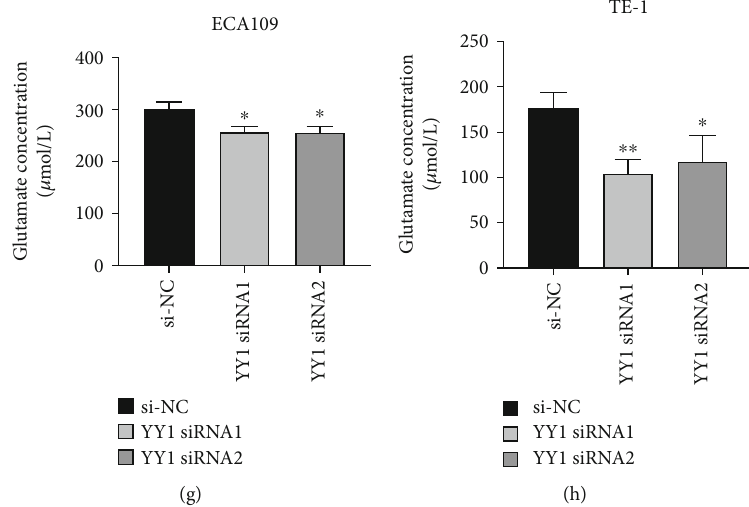
Figure 6: Silencing YY1 inhibited proliferation and glutamine metabolism of ECA109 and TE-1 cells. (a, b): Multiplication assays of ECA109 and TE-1 cells after siRNA knockdown of YY1. NC: negative control. Data are shown as the mean ± SD of three independent experiments. (c, d) The protein expressions of ASCT2, GLS, and GLUD1 in ECA109 and TE-1 cells after siRNA knockdown of YY1. (e, f) Analysis of the concentration of glutamate in ECA109 cells and TE-1 cells after siRNA knockdown of YY1. (g, h) Analysis of the consumption of glutamine in ECA109 cells and TE-1 cells after siRNA knockdown of YY1. ∗ P < 0 : 05 , ∗∗ P < 0 : 01 , and ∗∗∗ P < 0 : 001 ; n = 3